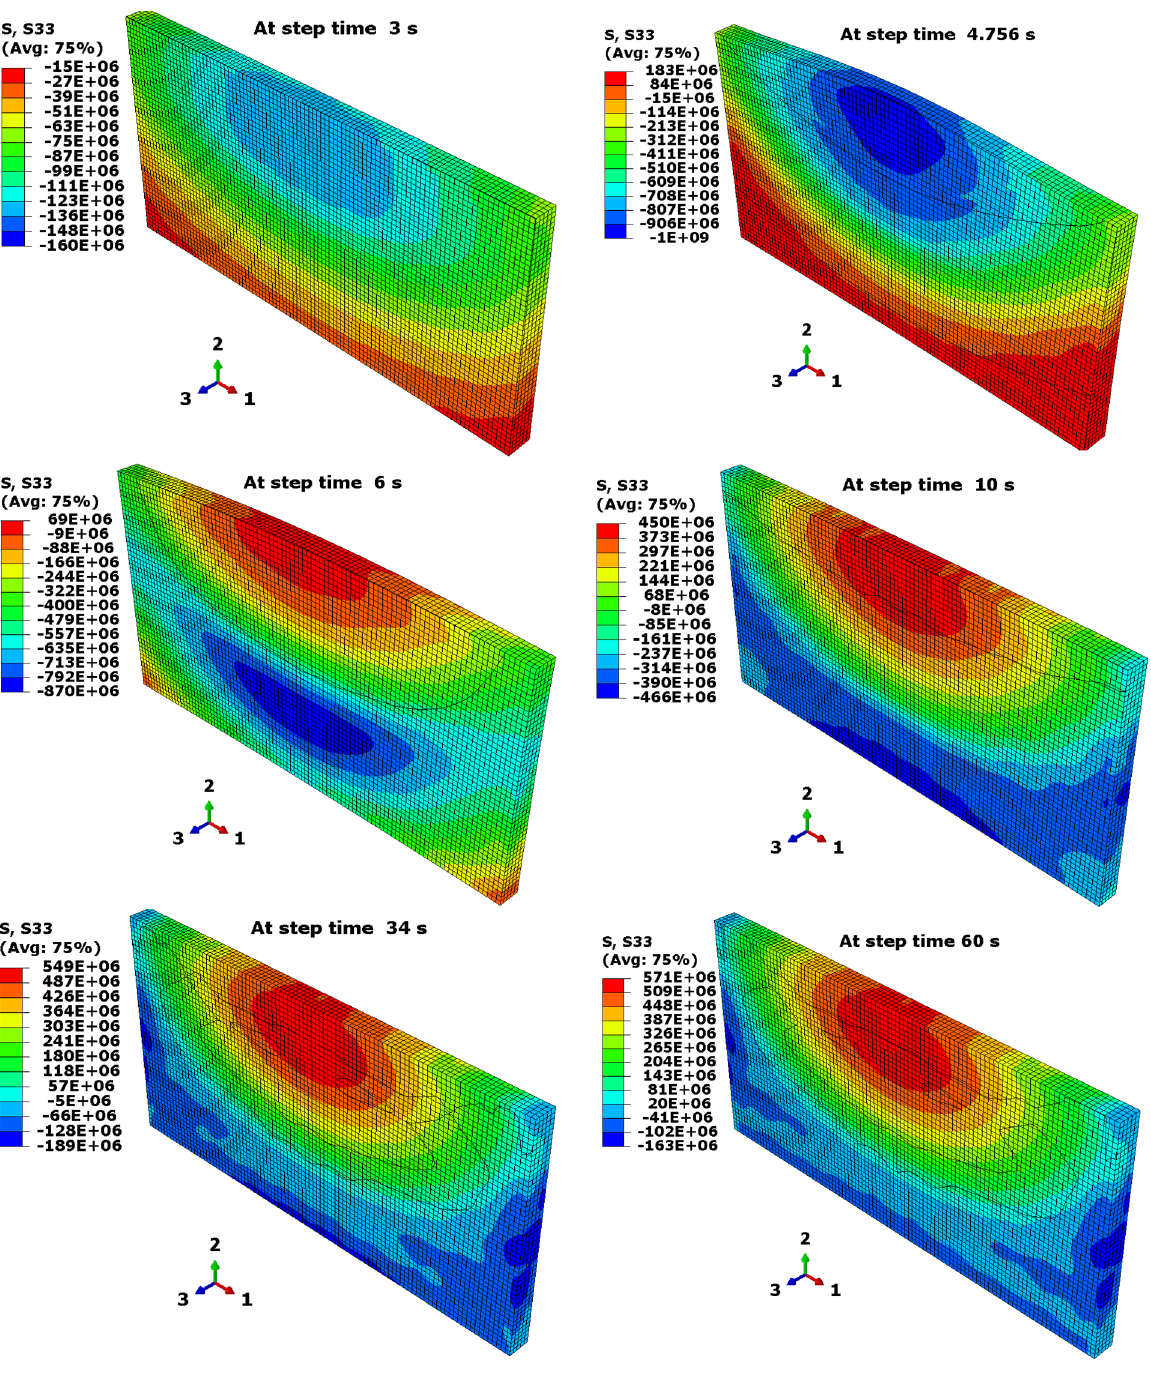
Figure 10. Evolution of the meso-level residual stresses (S33) at documented step times.